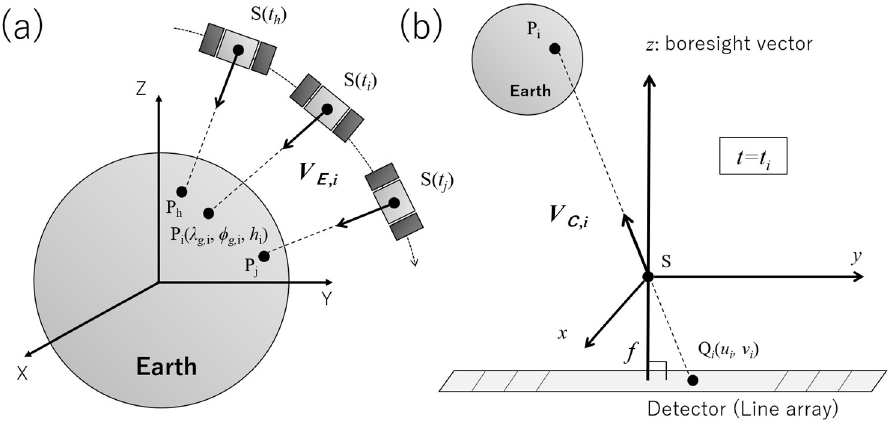
Figure 2. Schematic views of ( a ) V E, i ; and ( b ) V C, i . P i is point on Earth’s surface where land feature has been detected at scan time t = t i , and Q i is its projected point on detector plane. i , j , and h indicate different lines in observation sequence.